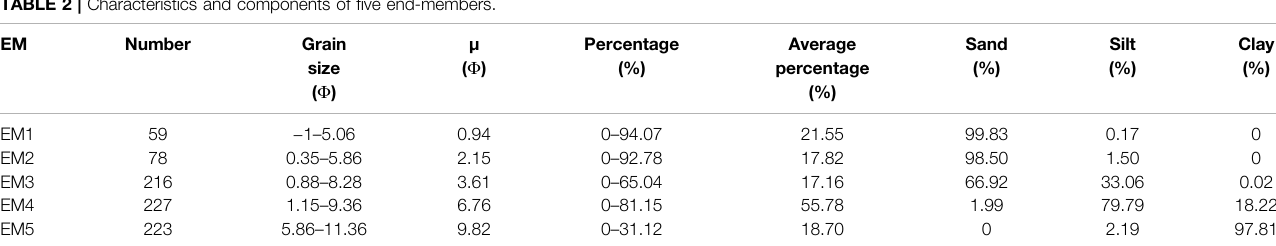
TABLE 2 | Characteristics and components of fi ve